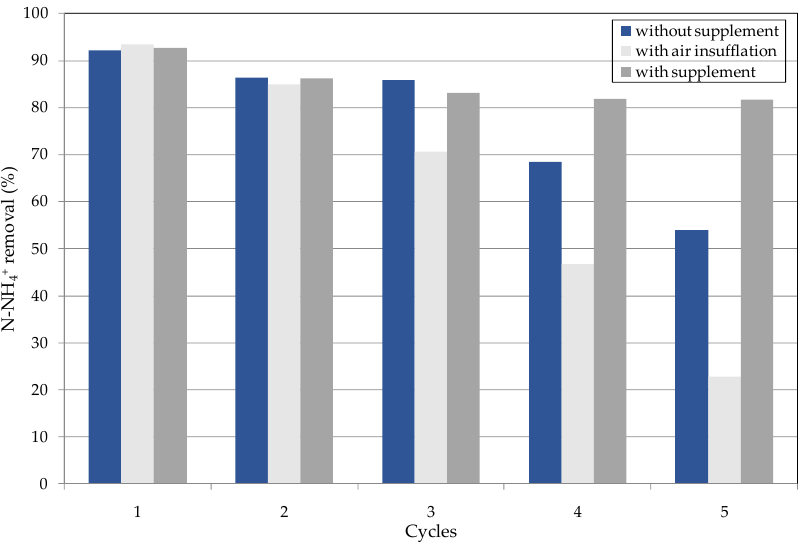
Figure 12. Ammonium removal during the repeated cycles conducted by using the struvite decomposition residues.